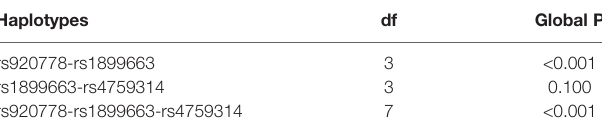
TABLE 4 | Association between haplotypes in HOTAIR and breast cancer risk.